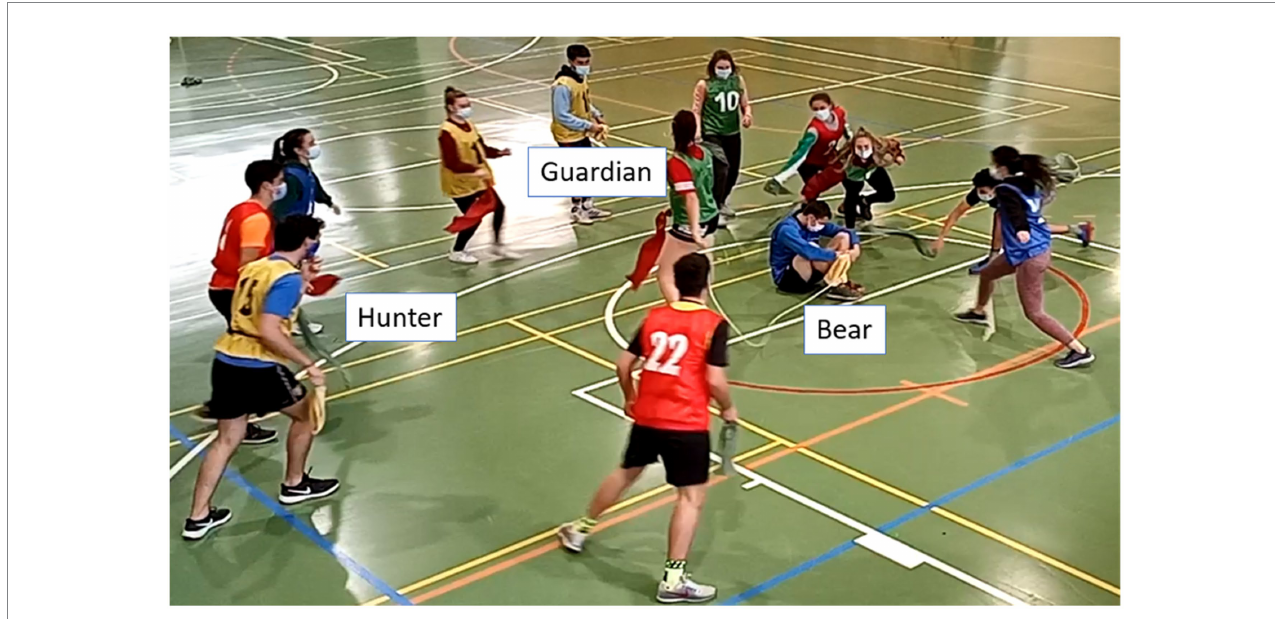
FIGURE 1 The roles in the Bear-Guardian and Hunter